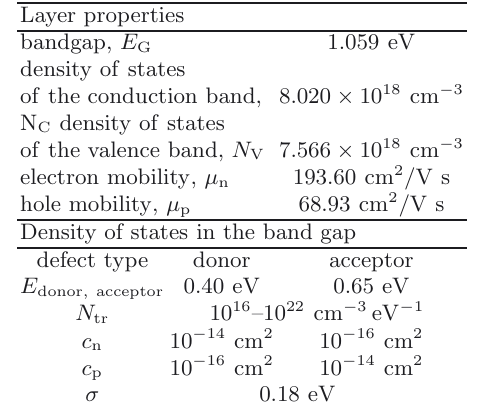
Table 2. Parameters of the GB layer. For the density of states in the band gap are specified: the energetic position of the maximum defect densities for the donor-type and the acceptor- type defect distribution E donor , acceptor , the maximum defect density of the distributions N tr , the capture cross sections for electrons and holes c n , p and the standard deviation σ .